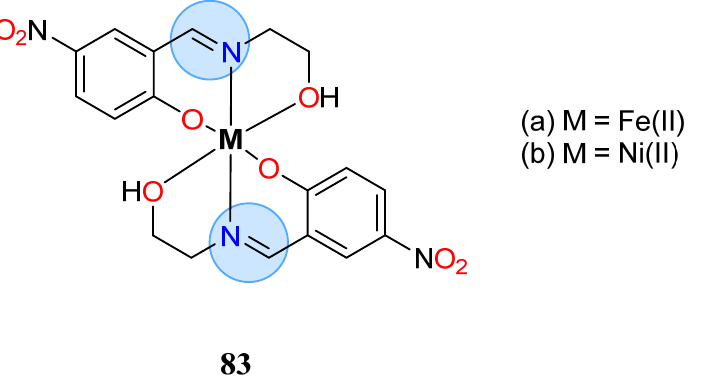
Figure 41. Iron(III) and copper (II) complexes of Schiff base ligand named (Z)-3-hydroxy-4-((5-methylthiophen-2-yl) methyleneamino)benzoic acid with antibacterial properties.